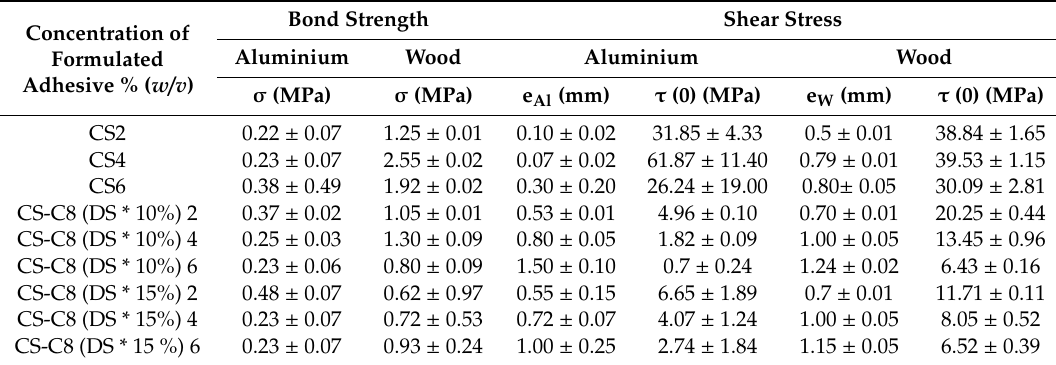
Table 1. Bond strength and shear stress of native and alkyl-chitosan adhesives on treated aluminium and wood adherends; e Al and e W are the adhesive thicknesses obtained on aluminium and wood adherends, respectively.